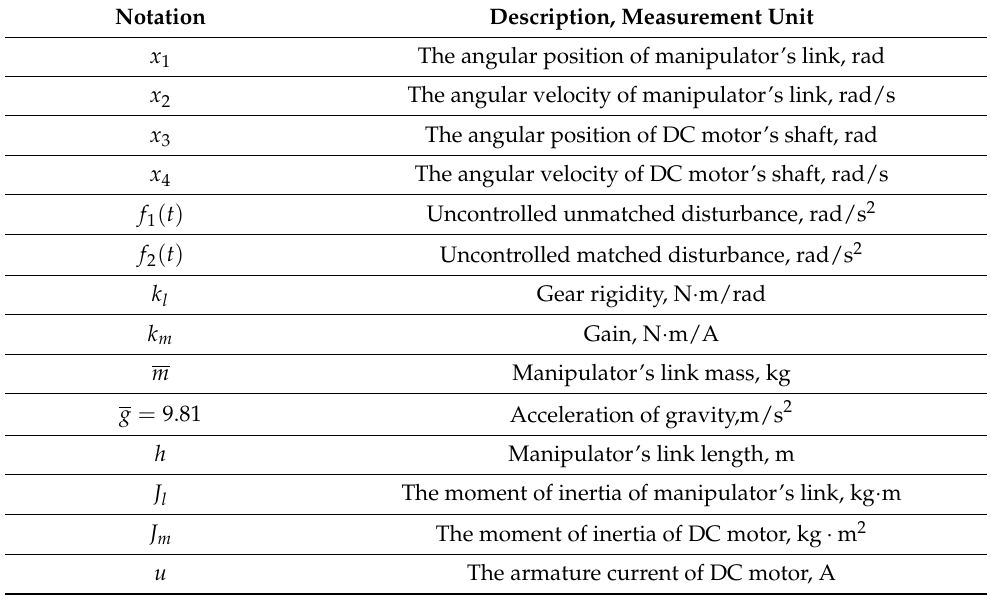
Table 1. The variables and parameters of the